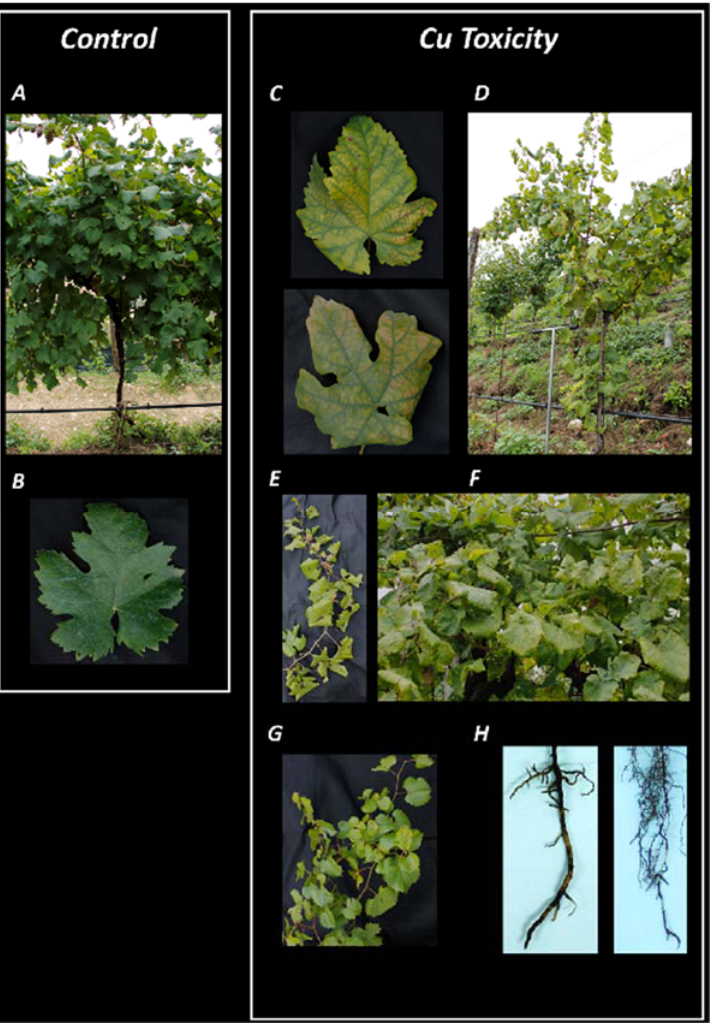
Figure 2. Symptoms of Cu toxicity in vine plants grown in a soil with 814 mg kg − 1 Cu (DTPA extractable fraction: 280 mg kg − 1 Cu): ( D – F ) canopy, ( C ) leaves and ( H ) roots of grafted plants rootstock SO4 ( V. berlandieri x V. riparia ). As control, canopy ( A ) and leaf ( B ) of healthy vine plants ( Vitis vinifera L. cv Glera ).